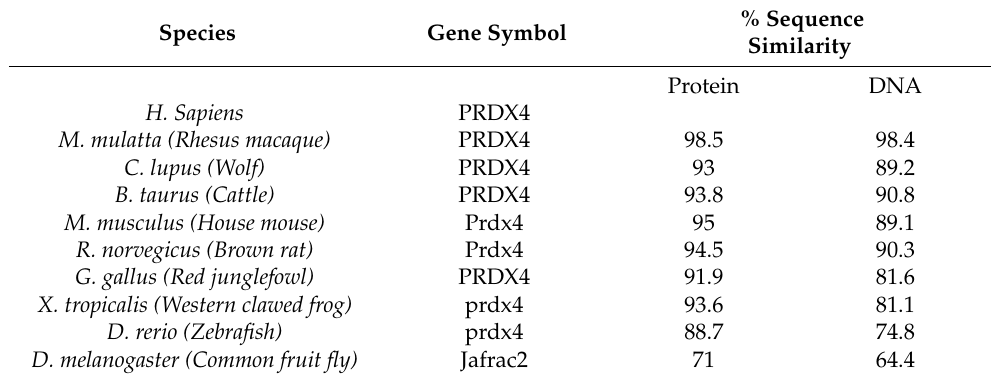
Table 1. Summary of human Prx4 homologues and conservation relative to human Prx4 generated using